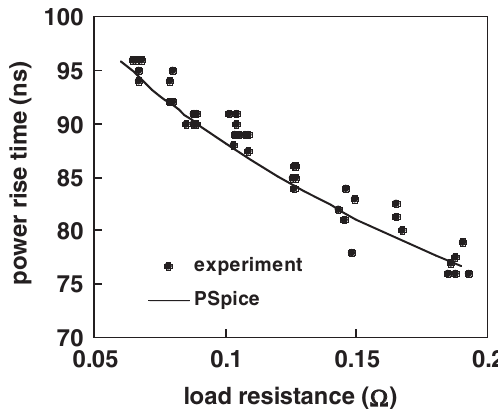
FIG. 5. Power rise time dependence on the load resistance. The experimental data points are compared with the PSPICE numeri- cal simulation (solid curve).